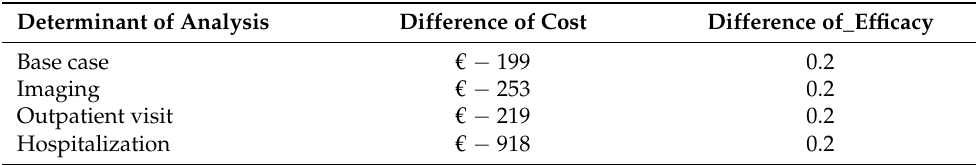
Table 4. Deterministic sensitivity analysis.